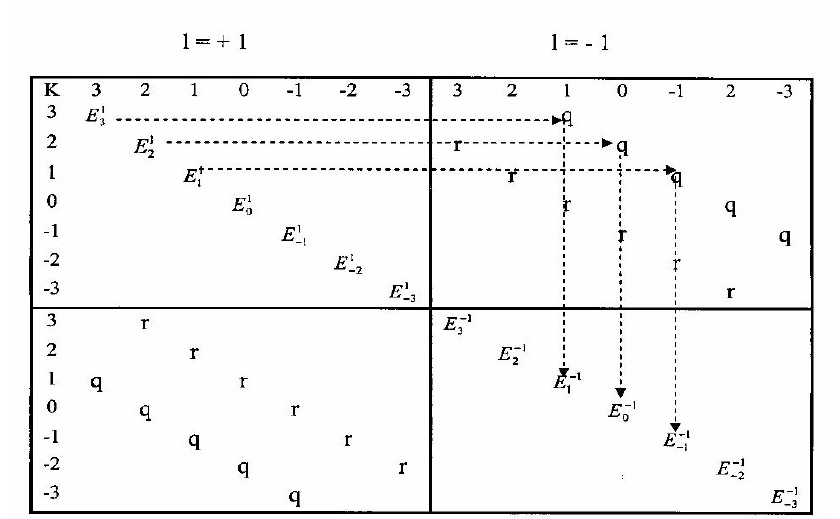
Figure 1. The Hamiltonian matrix for v